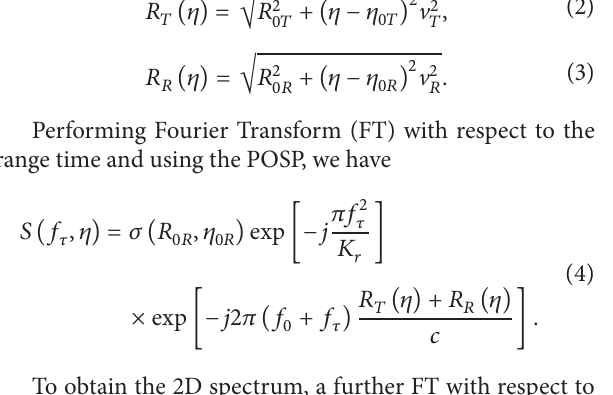
Figure 1: Bistatic SAR